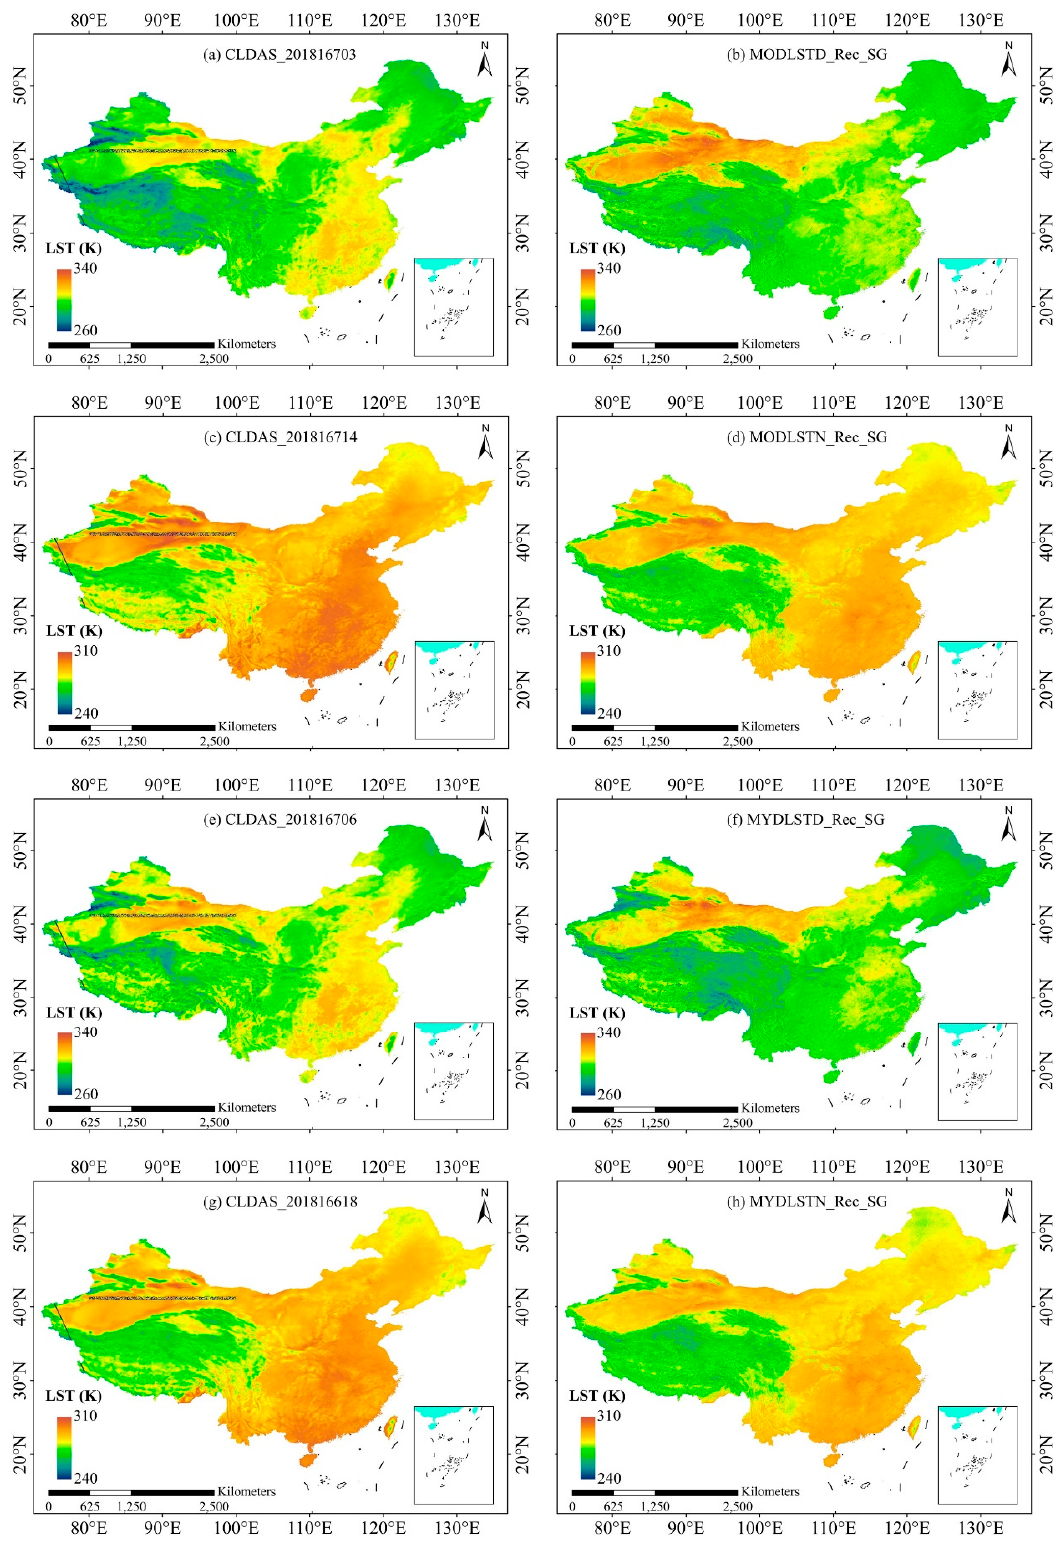
Figure 12. Comparison of the CLDAS LST data at UTC time: ( a ) CLDAS at 201816703; ( c ) CLDAS at 201816714; ( e ) CLDAS at 201816706; ( g ) CLDAS at 201816618, and the reconstructed MODIS LST data: ( b ) MODLSTD_Rec_SG; ( d ) MODLSTN_Rec_SG; ( f ) MYDLSTD_Rec_SG; ( h ) MYDLSTN_Rec_SG; 201816703, 201816714, 201816706, and 201816618 (UTC time) denote corresponding time at 11:00 a.m., 22:00 p.m., 2:00 p.m., and 2:00 a.m. on DOY 167 of 2018 (Beijing time) of the four CLDAS LST products, respectively.